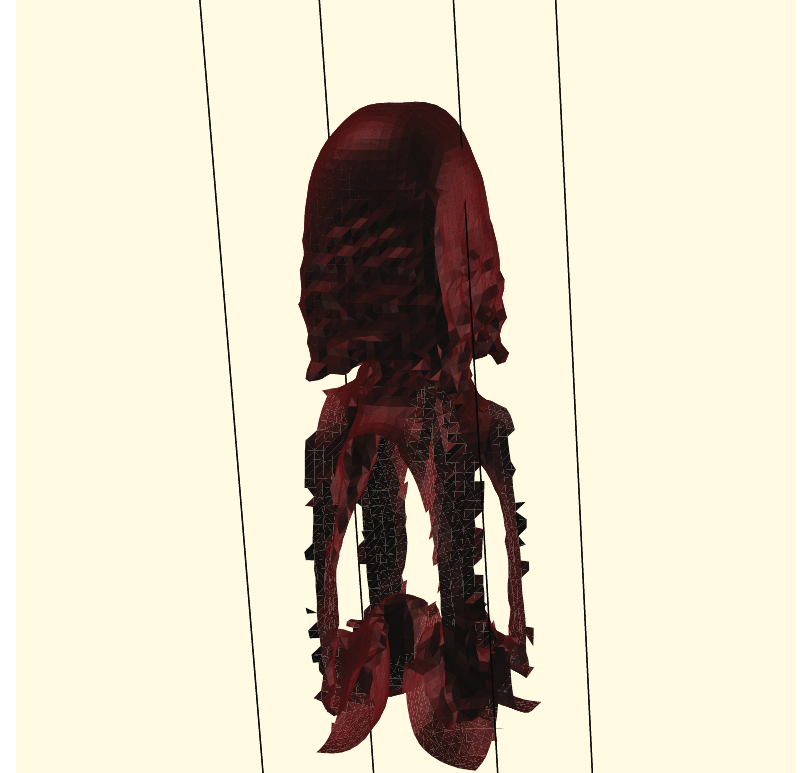
Figure 4: Plot of middle time for Rayleigh-Taylor fl uid instability. Flow and grid parameters as in Figure